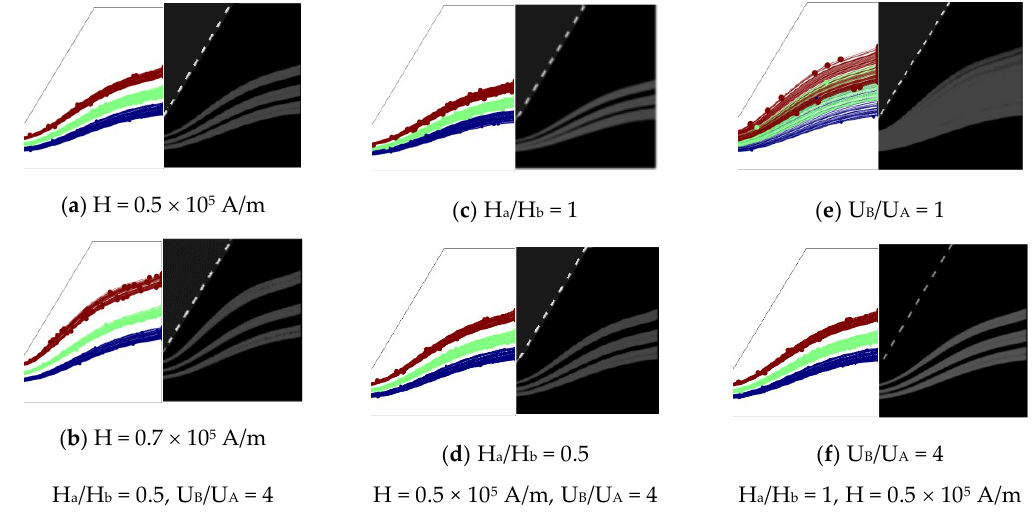
Figure 12. Qualitative comparison of the numerical and experimental results. Table 4. Quantitative comparison of the numerical and experimental